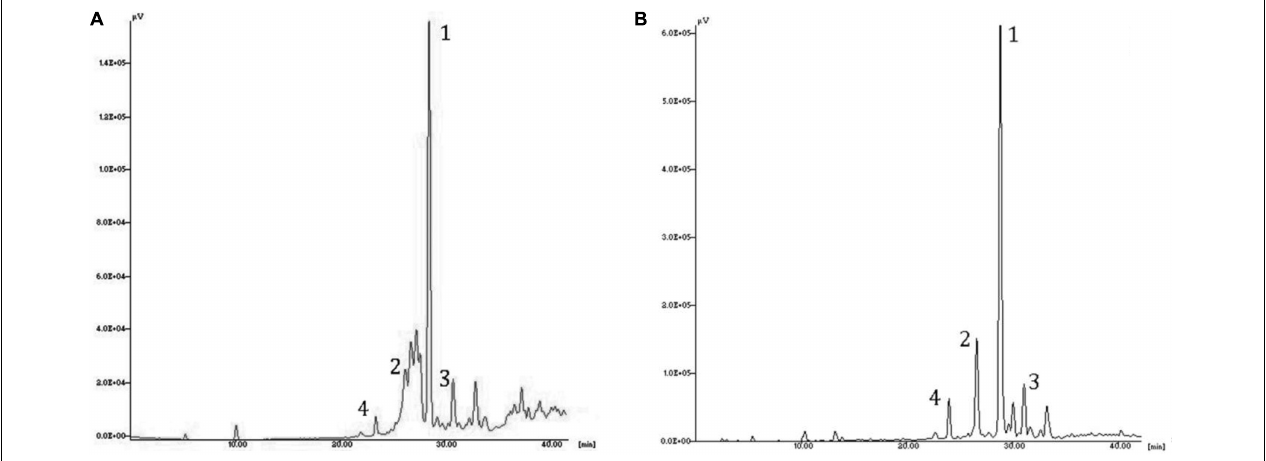
Frontiers in Bioengineering and Biotechnology |